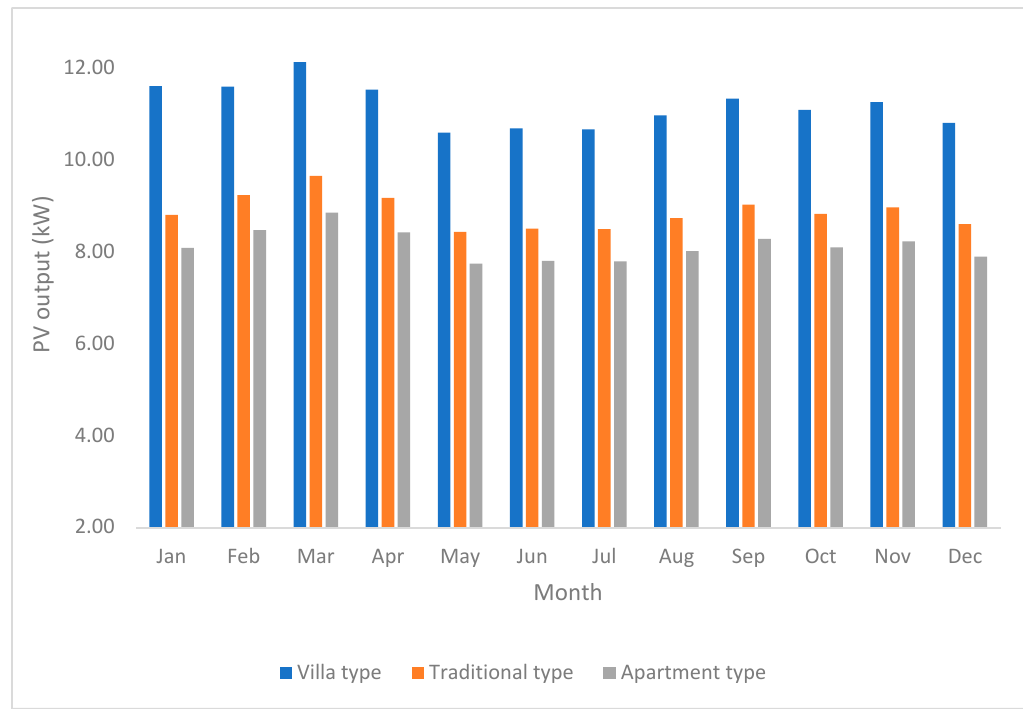
Figure 7. Simulated monthly average energy yield for villa, traditional house, and apartment.